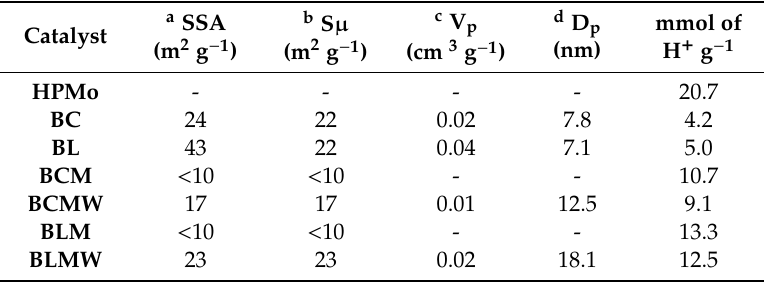
Figure 4. Distribution of the pore size and the N 2 adsorption-desorption curve of the natural, modified and washed samples. ( a ) BC, BCM, BCMW; ( b ) BC, BCM, BCMW; ( c ) BL, BLM, BLMW; ( d ) BL, BLM, BLMW. Table 2. Specific surface area, porous area, porous volume and surface acidity.